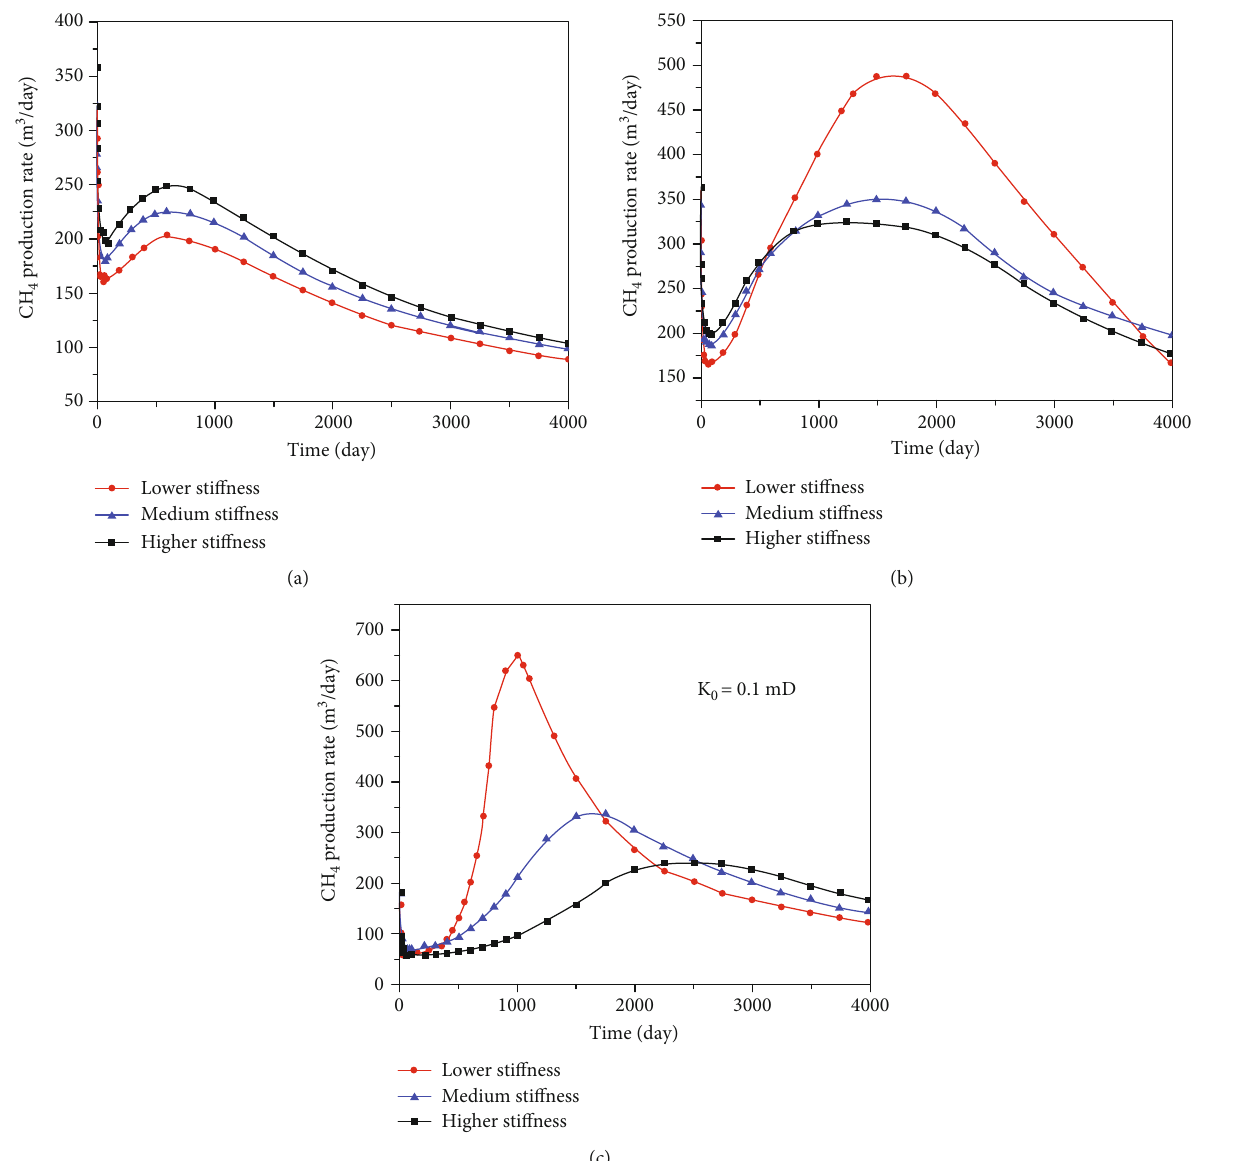
Figure 9: CH production rate under di ff erent reservoir geomechanical properties. (a) Primary production. (b) CO 4